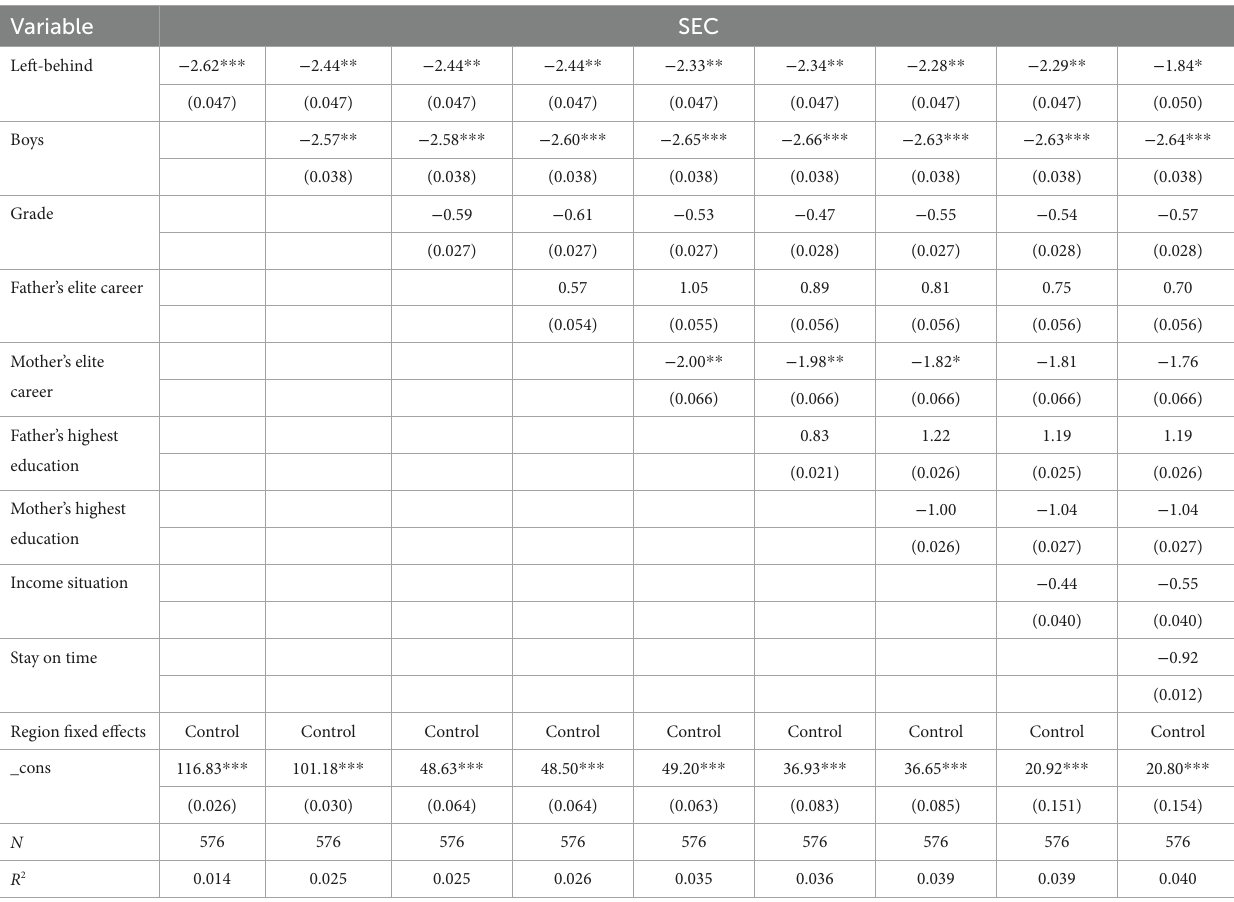
TABLE 2 Ordinary least square (OLS) regression results of the effect of being left behind on children’s SEC. Variable